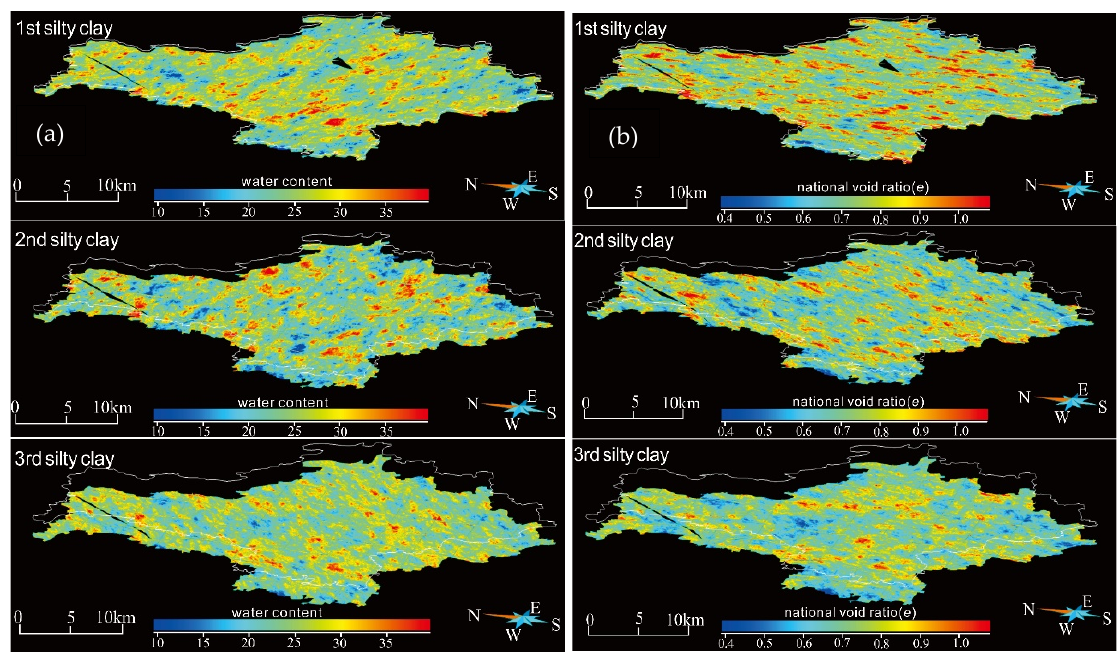
Figure 14. Three-dimensional property model of ( a ) water content (w%); and ( b ) national void ratio ( e ) .